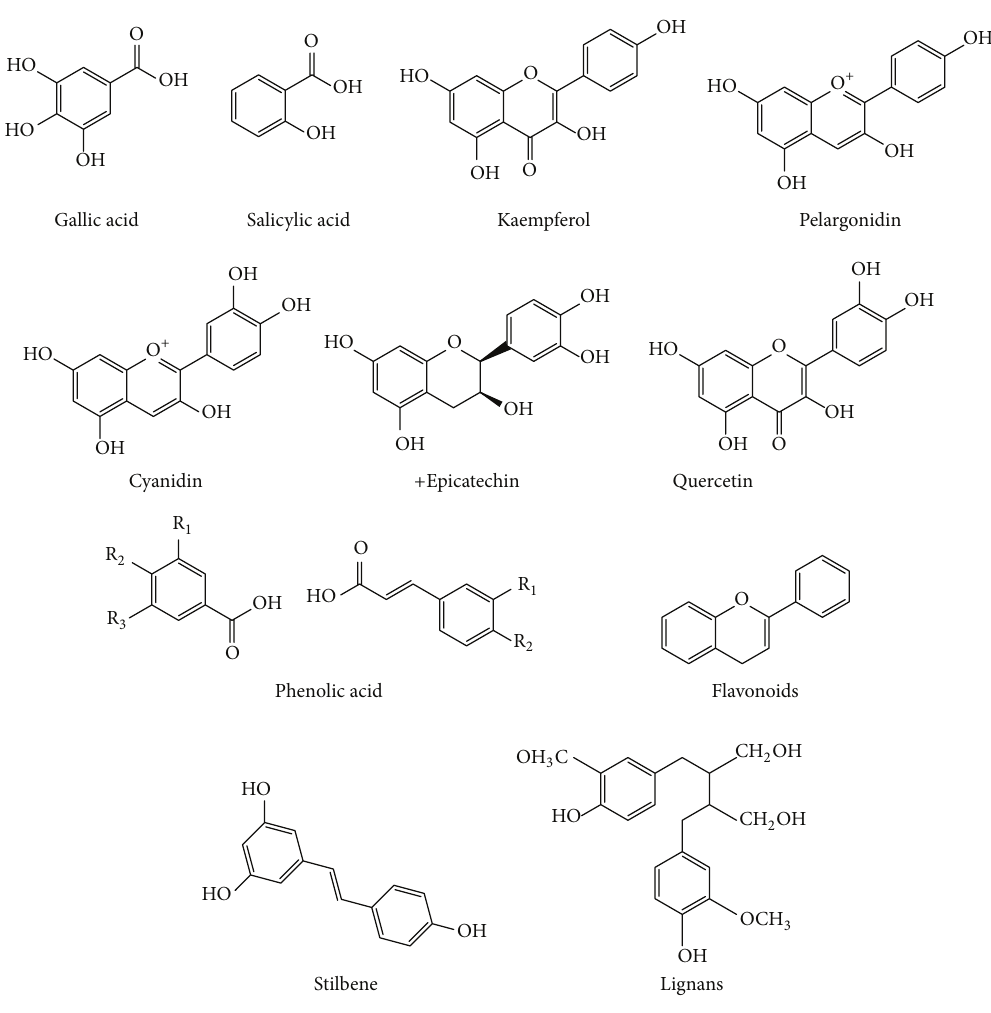
Figure 1: Structure of polyphenols found in